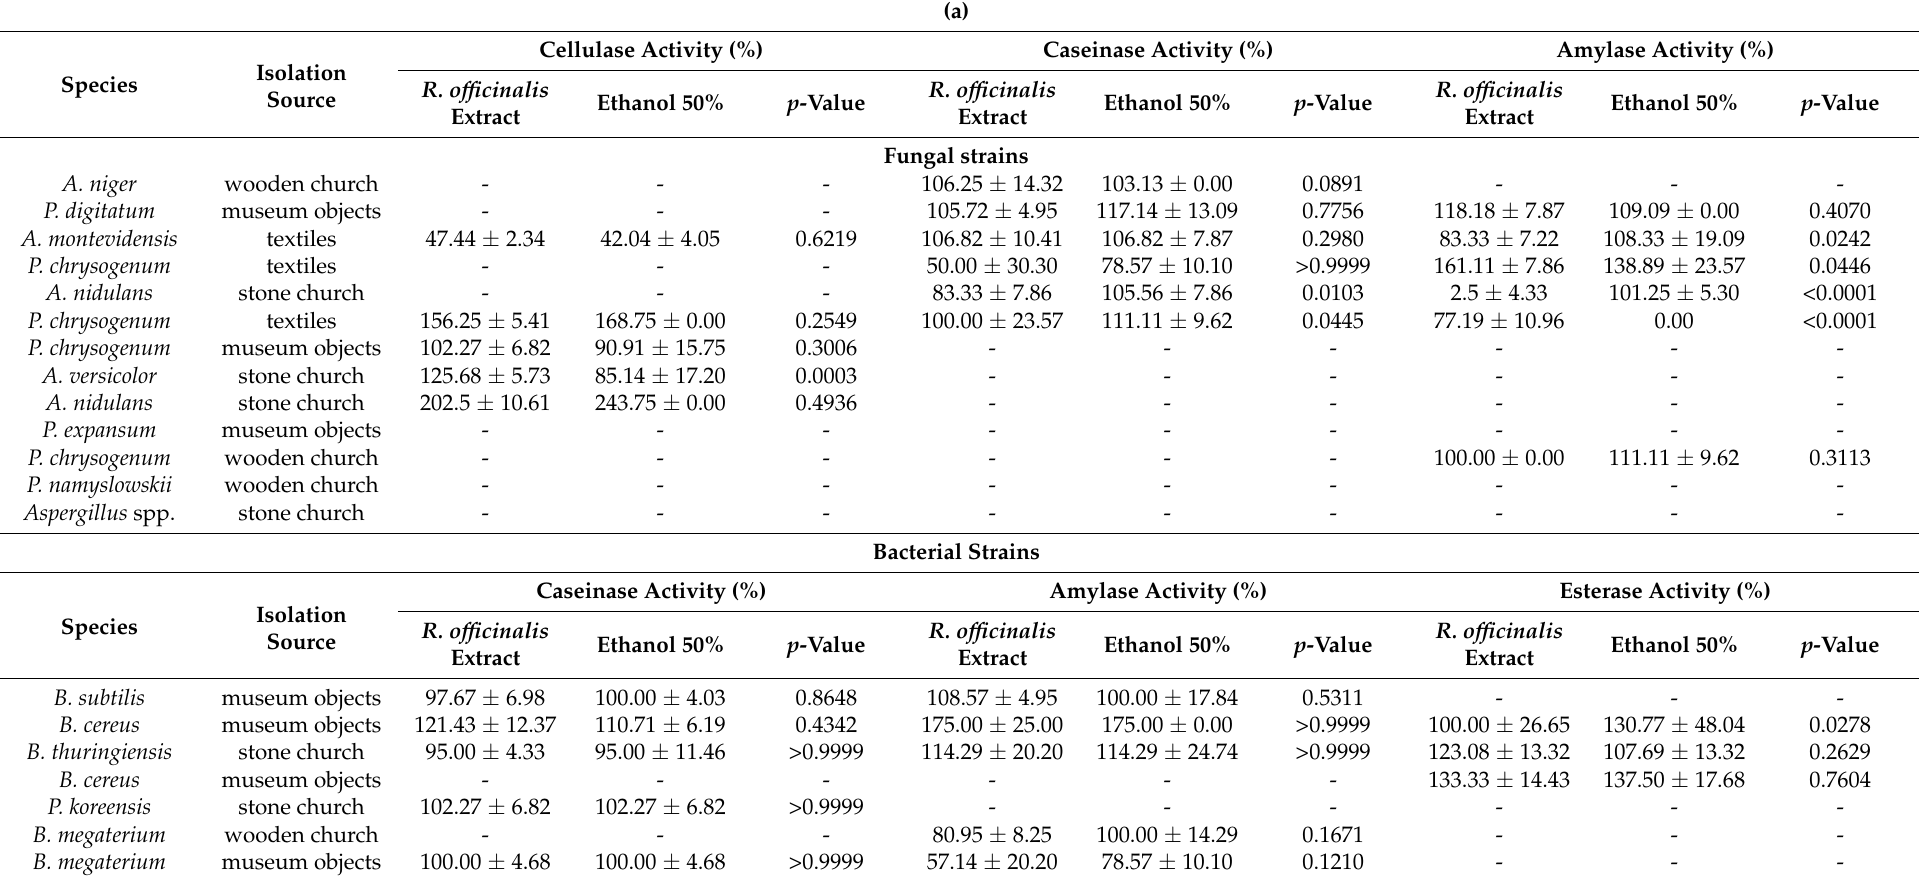
Table 5. ( a ) The influence of R. officinalis extract and ethanol (50%) control on the production of enzymatic factors involved in biodeterioration. ( b ) The influence of R. officinalis extract and ethanol (50%) control on the organic acid